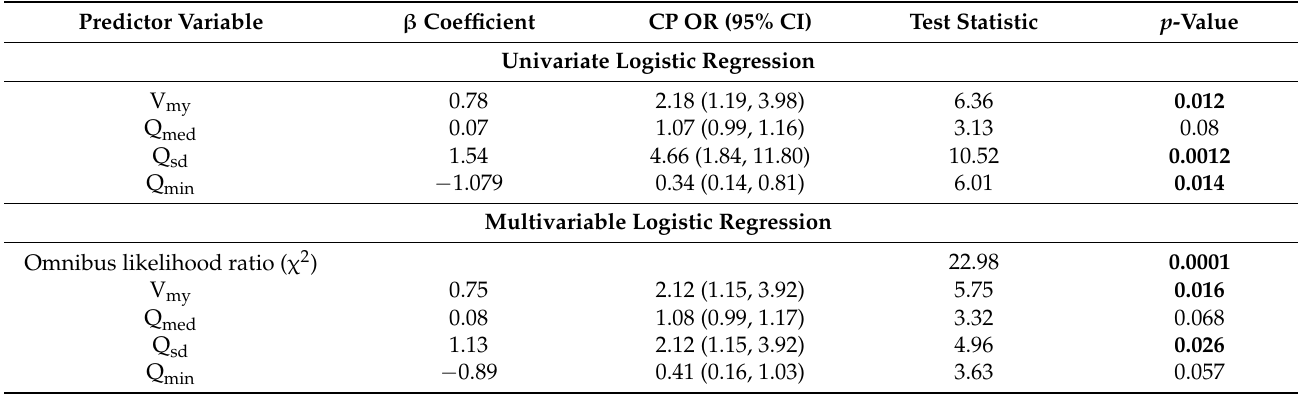
Table 2. Univariate and multivariate logistic regression